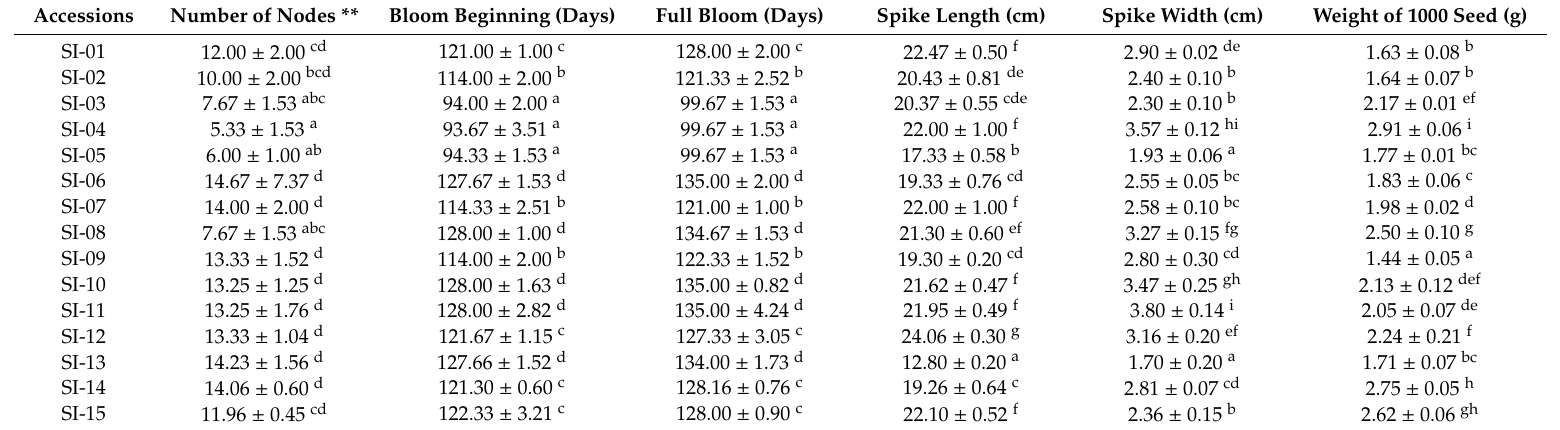
Table 3. Morphological characteristics of the selected accessions of S.